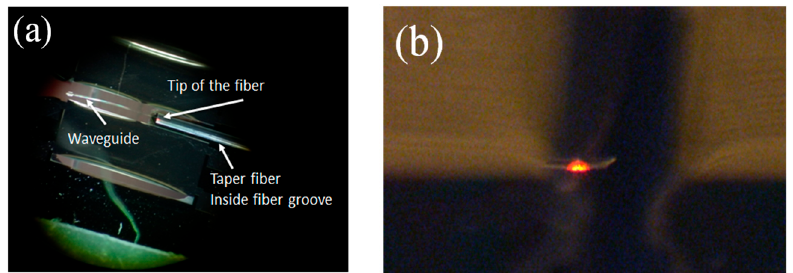
Figure 19. ( a ) Optical coupling from the taper fiber to the SU8 rib waveguide. ( b ) Light observed at the tip of the SU8 rib waveguide. Light appears nicely confined inside the core of the waveguide. Table 3. Light coupling measurements.